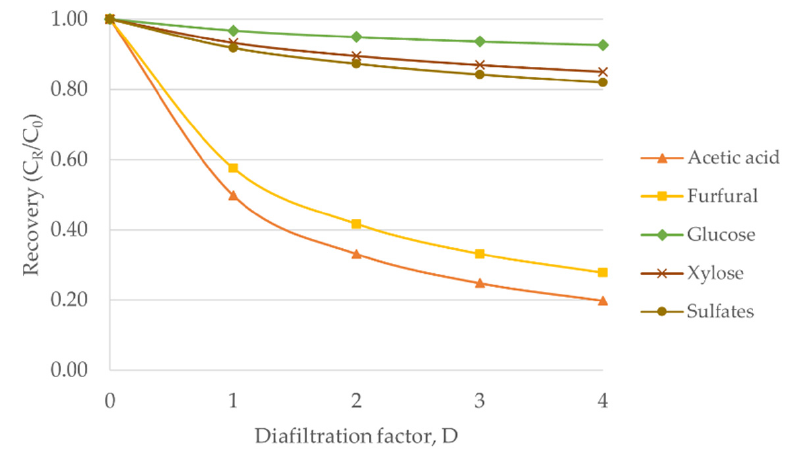
Figure 6. Estimated effects of diafiltration by NF99HF membrane.